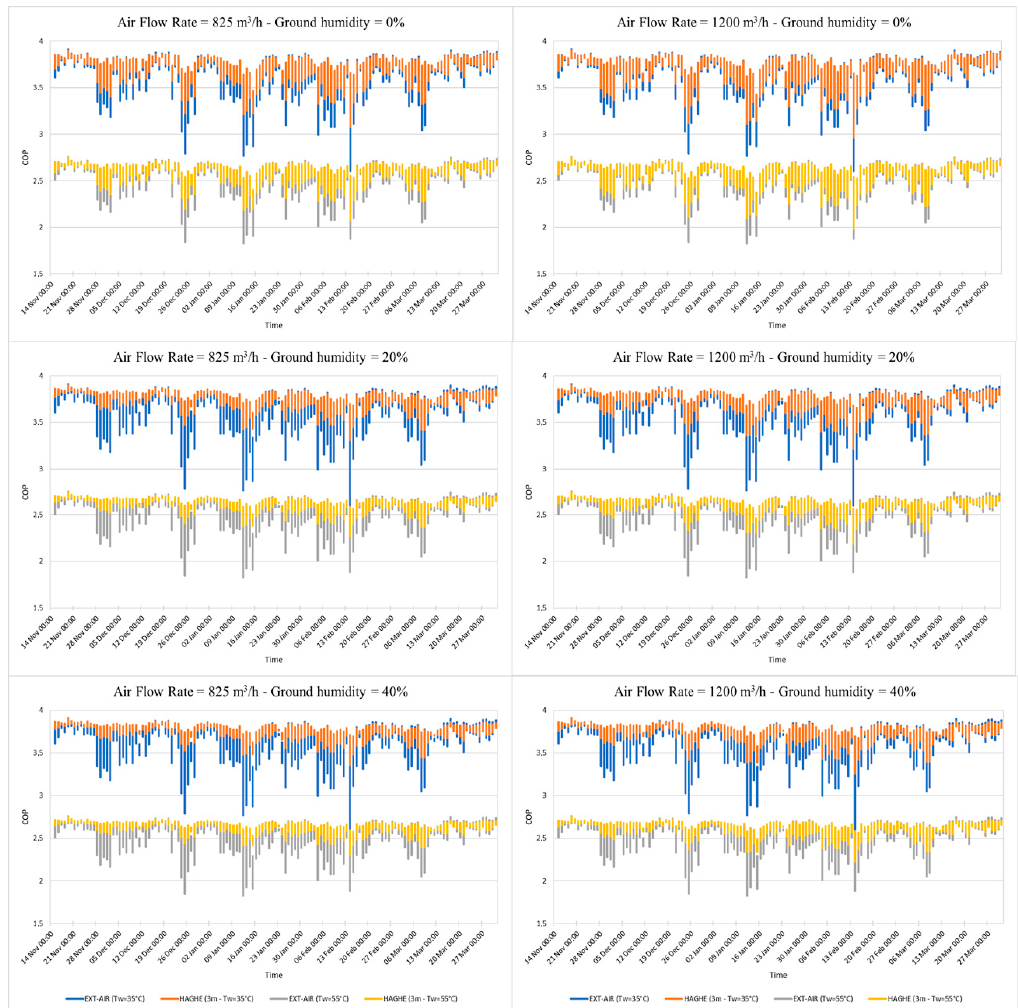
Figure 5. Winter comparison between COP EXT ‐ AIR and COP HAGHE by varying T w , ground volumetric humidity and the air flow rate: 15 November–31 March, H = 3 m, L = 30 m.